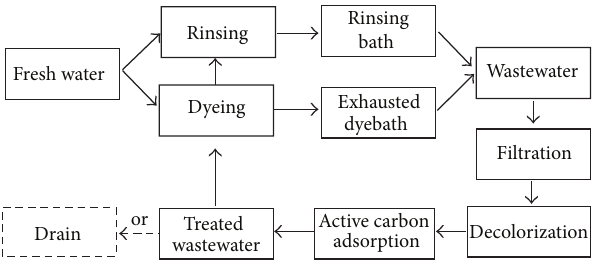
Figure 1: Schematic of degradation and reuse processes of reactive dyeing